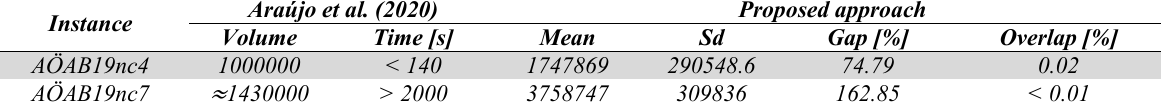
Results of the instances: AÖAB19 nc4 and AÖAB19